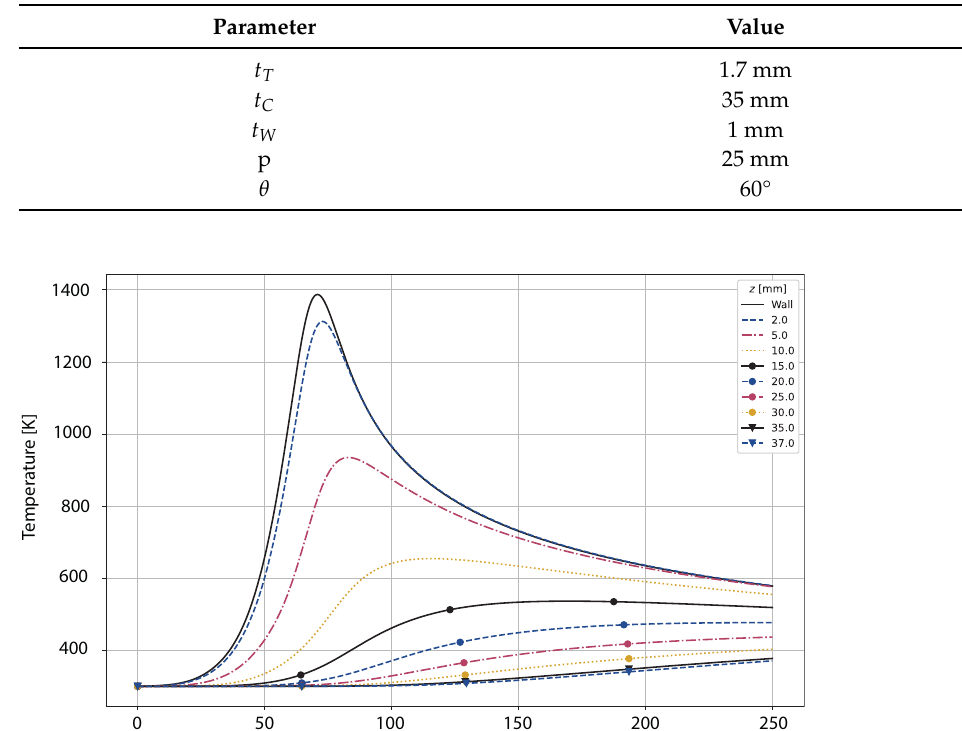
Table 3. Optimized geometric parameters for the corrugated core ITPS.